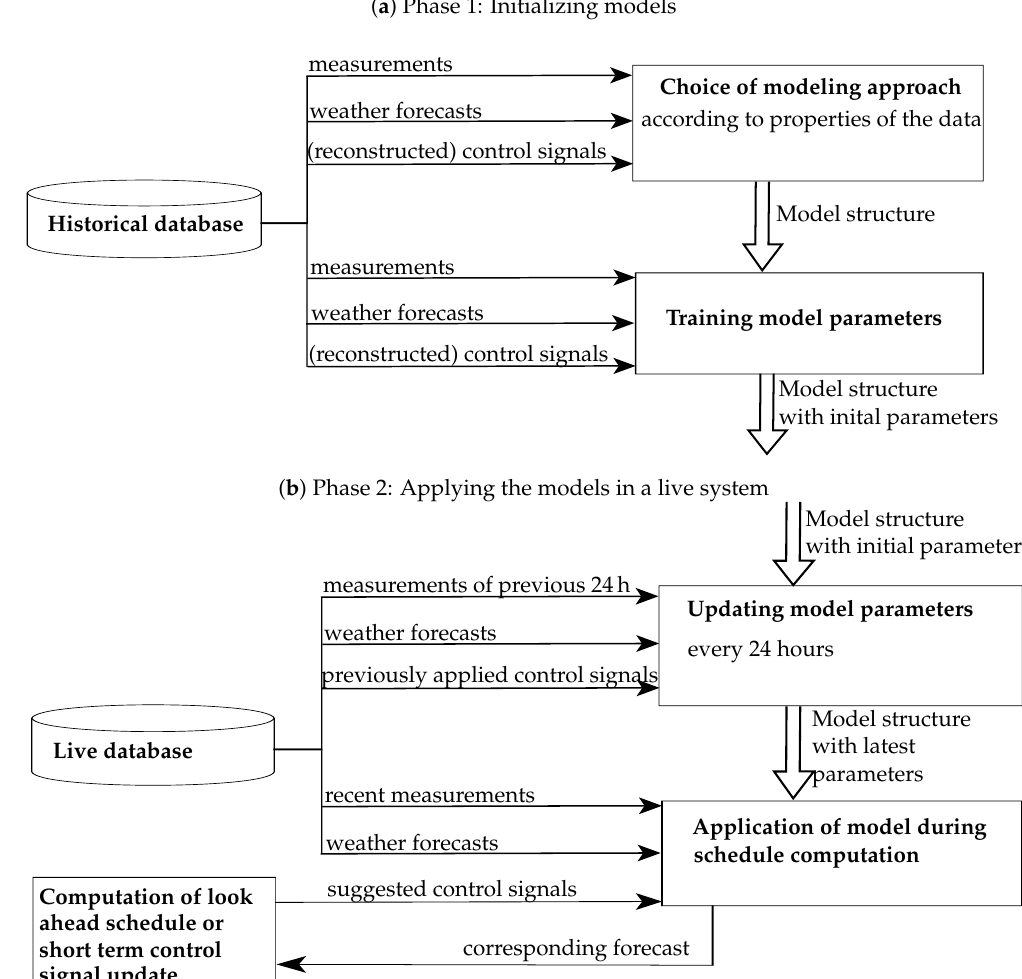
Figure 2. General workflow of the data-based modeling approach for generation plants and devices consuming power. During the first phase, a training phase of the system, the acquired data are used to select a model structure and to train model parameters. Apart from the power consumption data, some devices require weather data (measurements and/or forecasts) and control signals. During the second phase, the operational phase, the models, together with the data generated during the live operation of the demonstration site, are used to generate forecasts and model parameters are adapted to new